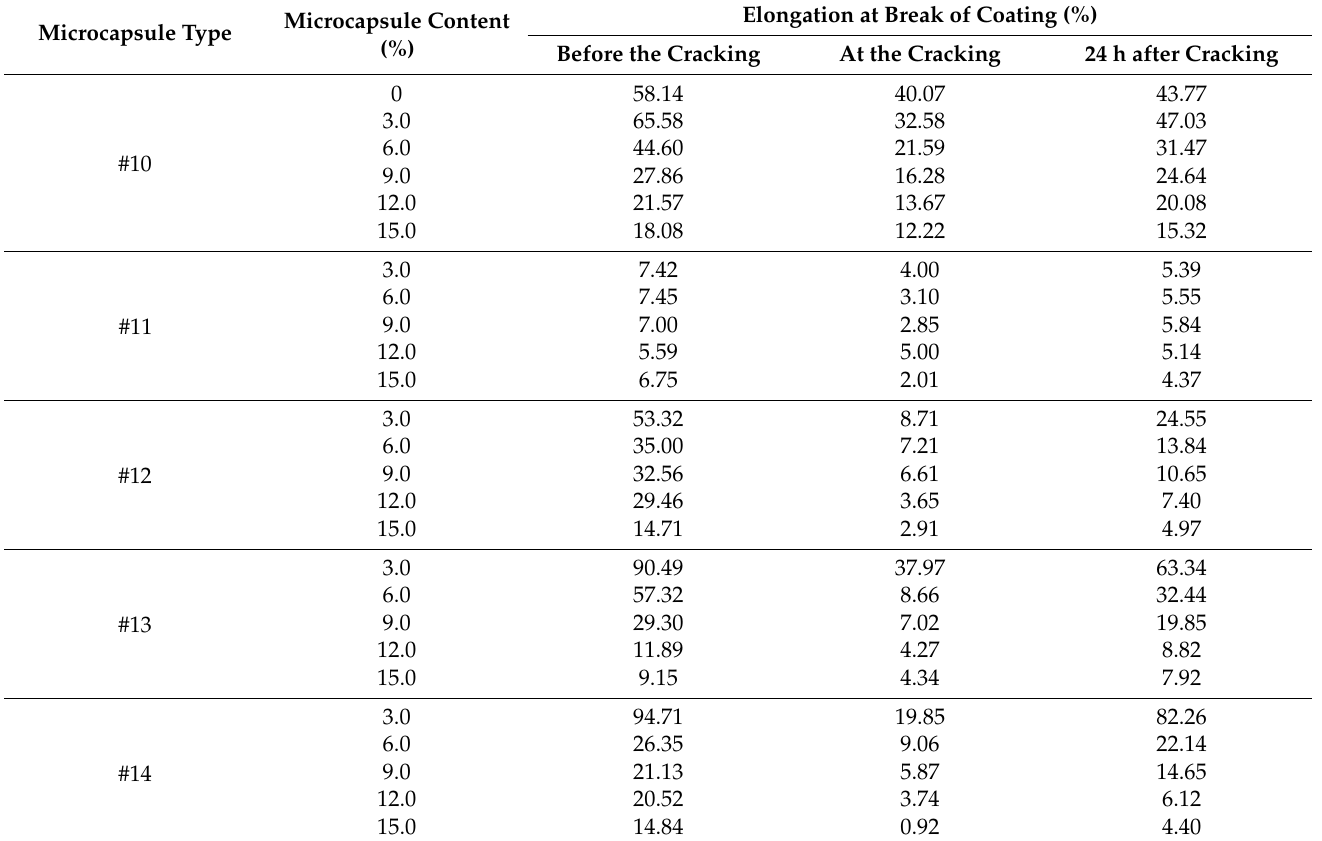
Table 10. Elongation at break results of waterborne coatings with different microcapsules under three